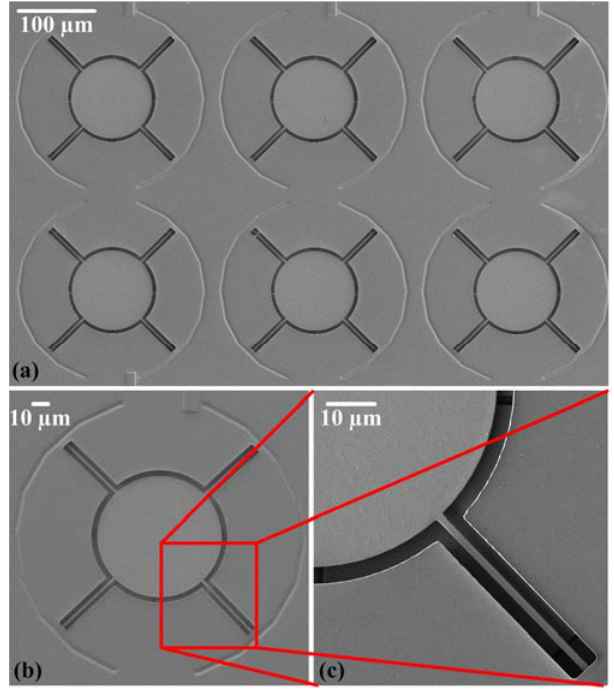
Figure 6. SEM images of (a) the micromirror array, (b) a single mirror, and (c) the beams of the micromirror array, after the post-processing.